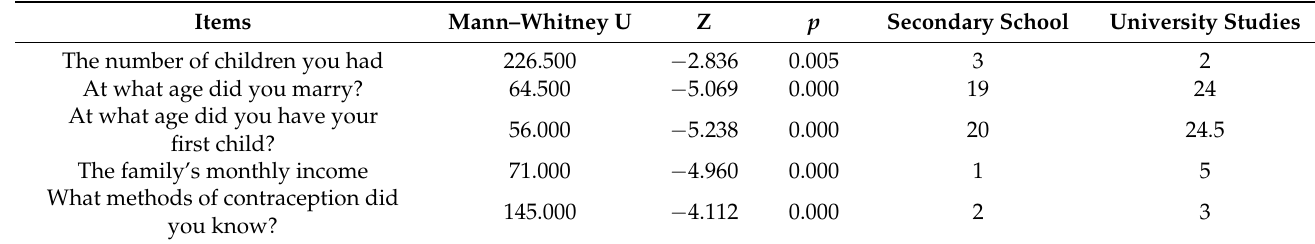
Table 5. Comparative results considering the level of education 1